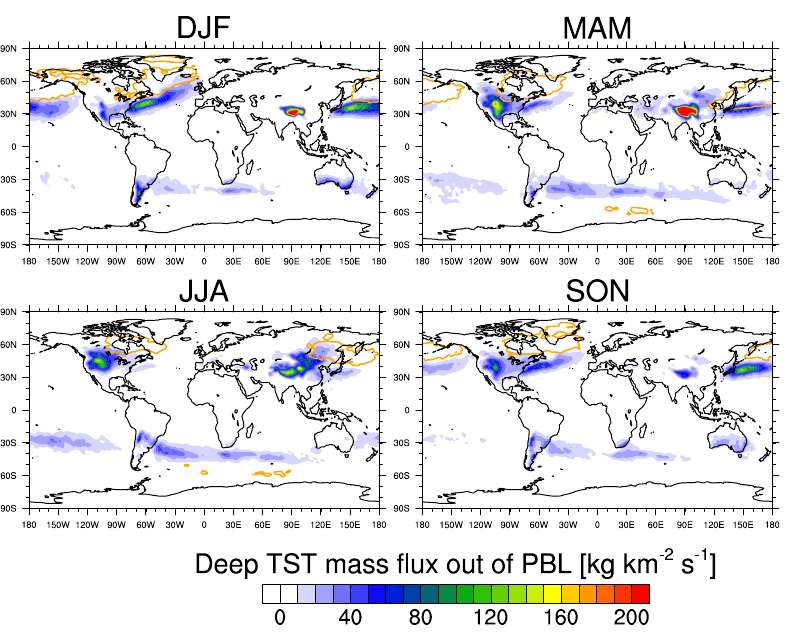
Fig. 6. Seasonally averaged deep TST mass flux out of the PBL for 1979–2011. The orange contours indicate areas where the mass flux across the tropopause due to deep TST is higher than 25kgkm − 2 s − 1 .